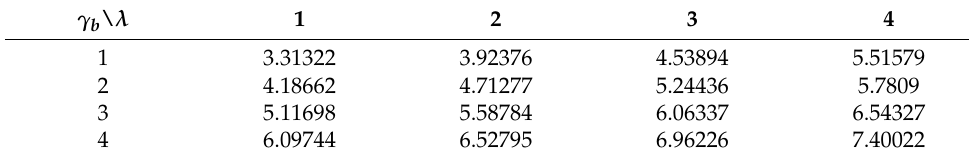
1 2 e for λ versus γ b . C f R 2